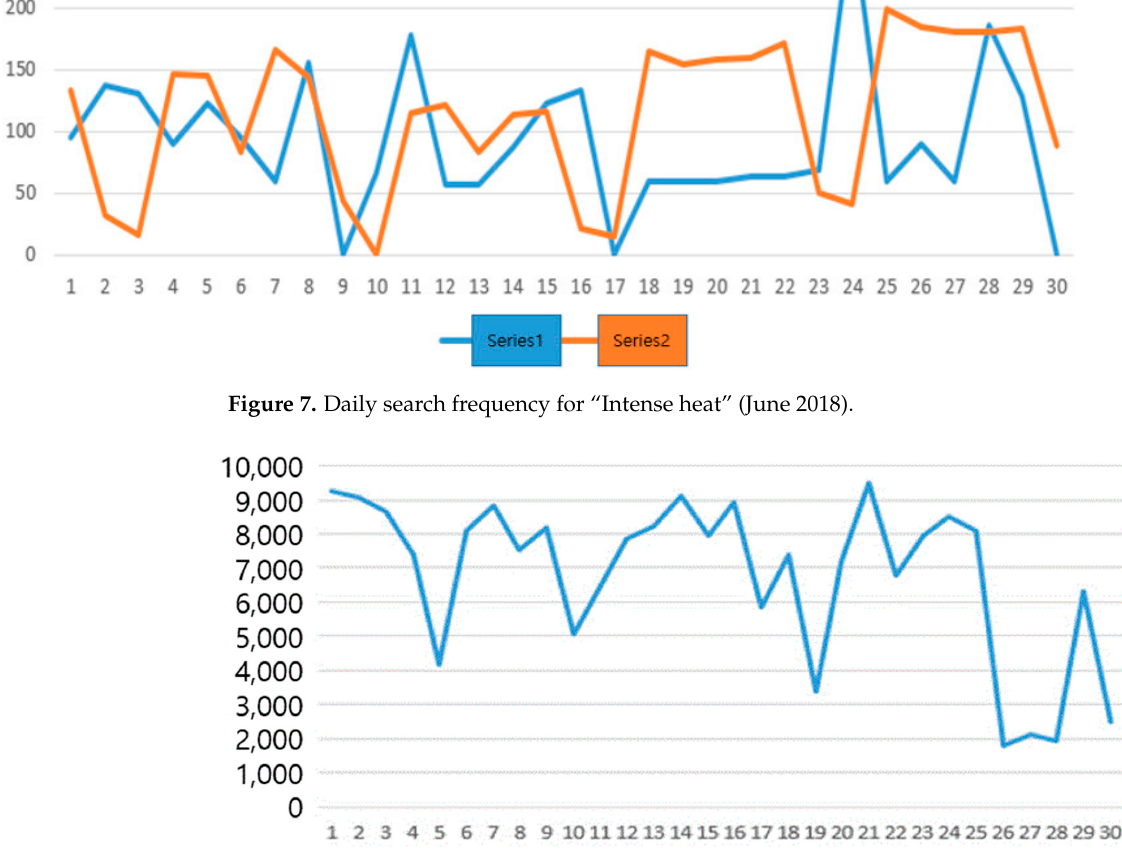
Figure 8. Yeongam Photovoltaic Power Plant Power generation in June 2018.